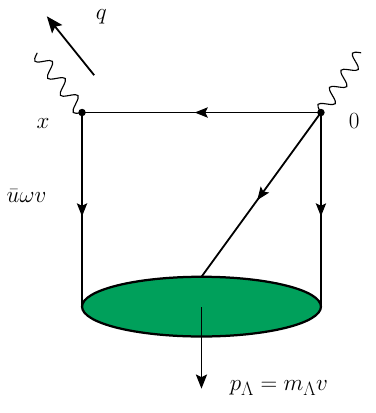
Fig. 1 Feynman diagram of the QCD level correlation function. The green ellipse denotes the final (cid:2) Q (cid:3) which has velocity v . The left black dot denotes the V − A current while the right dot denotes the doubly- heavy baryon current. The left straight line denote one of the light quark insidethe (cid:2) Q (cid:3) .Ithasmomentum ¯ u ωv ,where ¯ u isitsmomentumfraction related to the